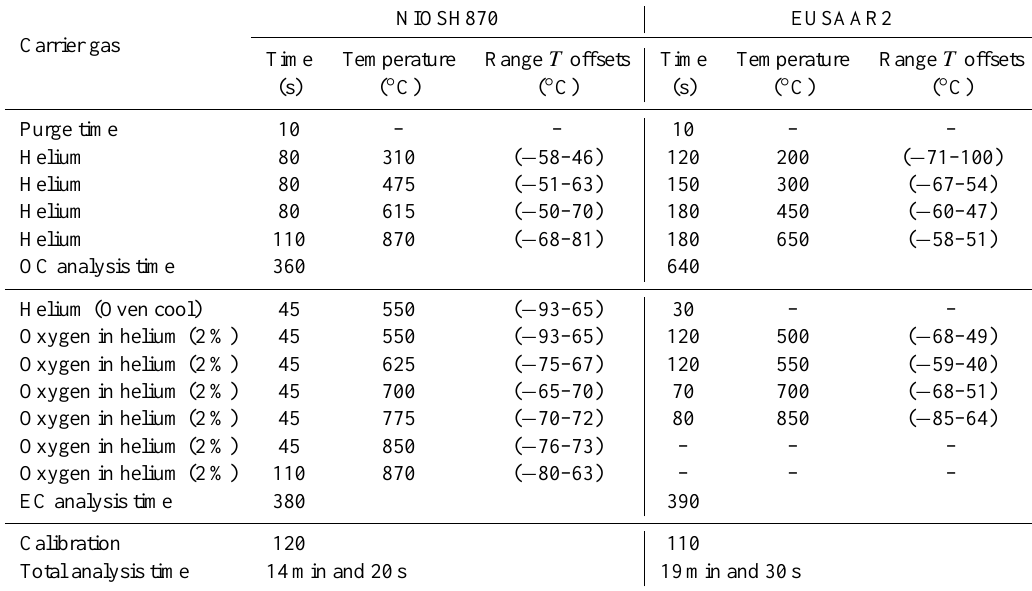
Table 2. Details of the two thermal protocols applied by the participants and observed temperature offset range per step.